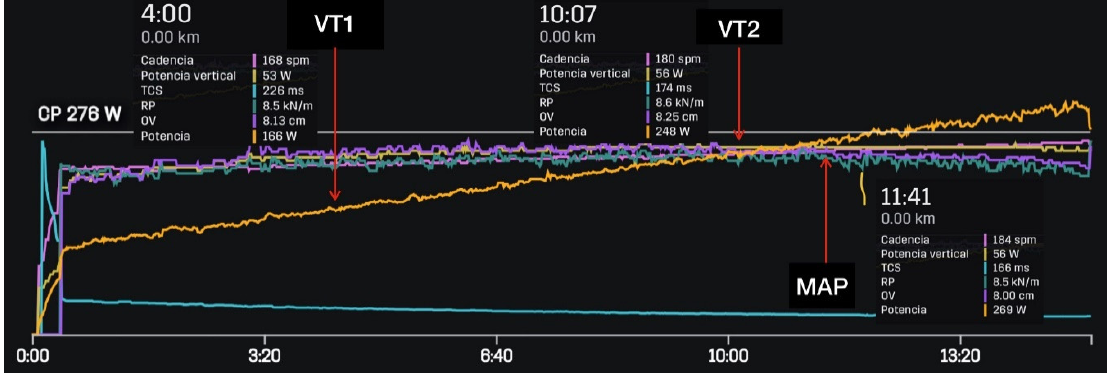
Figure 1. Determination of the ventilation thresholds 1 and 2 (VT1 and VT2) and maximal aerobic power (MAP) with the corresponding power at each physiological threshold.